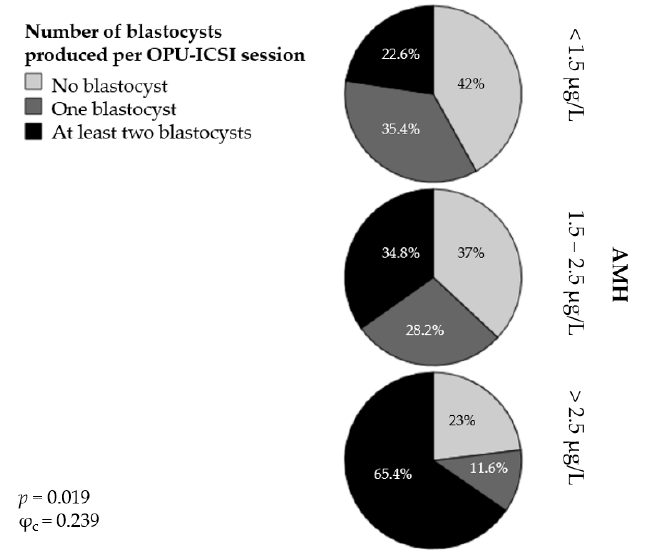
Figure 3. Percentages of mares producing no blastocysts, one blastocyst, or at least two blastocysts per OPU-ICSI session in three groups of mares with different serum AMH concentrations.